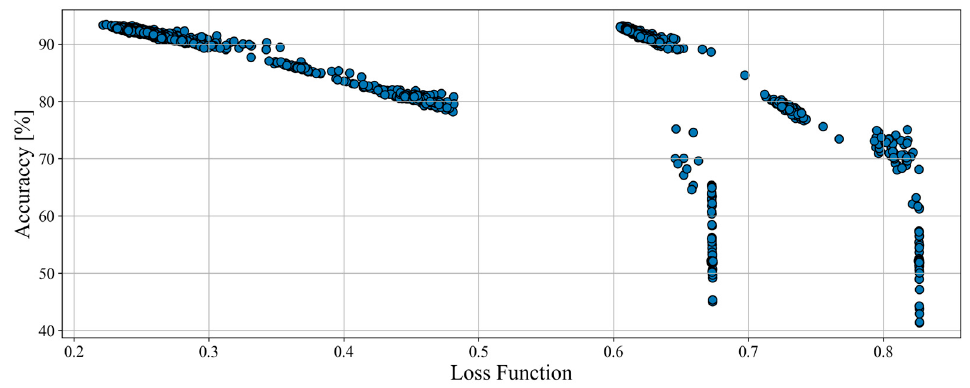
Figure 6. Accuracy and value of loss function of params combinations examined during the hy- perparameters optimization process for haul trucks. rameters optimization process for haul